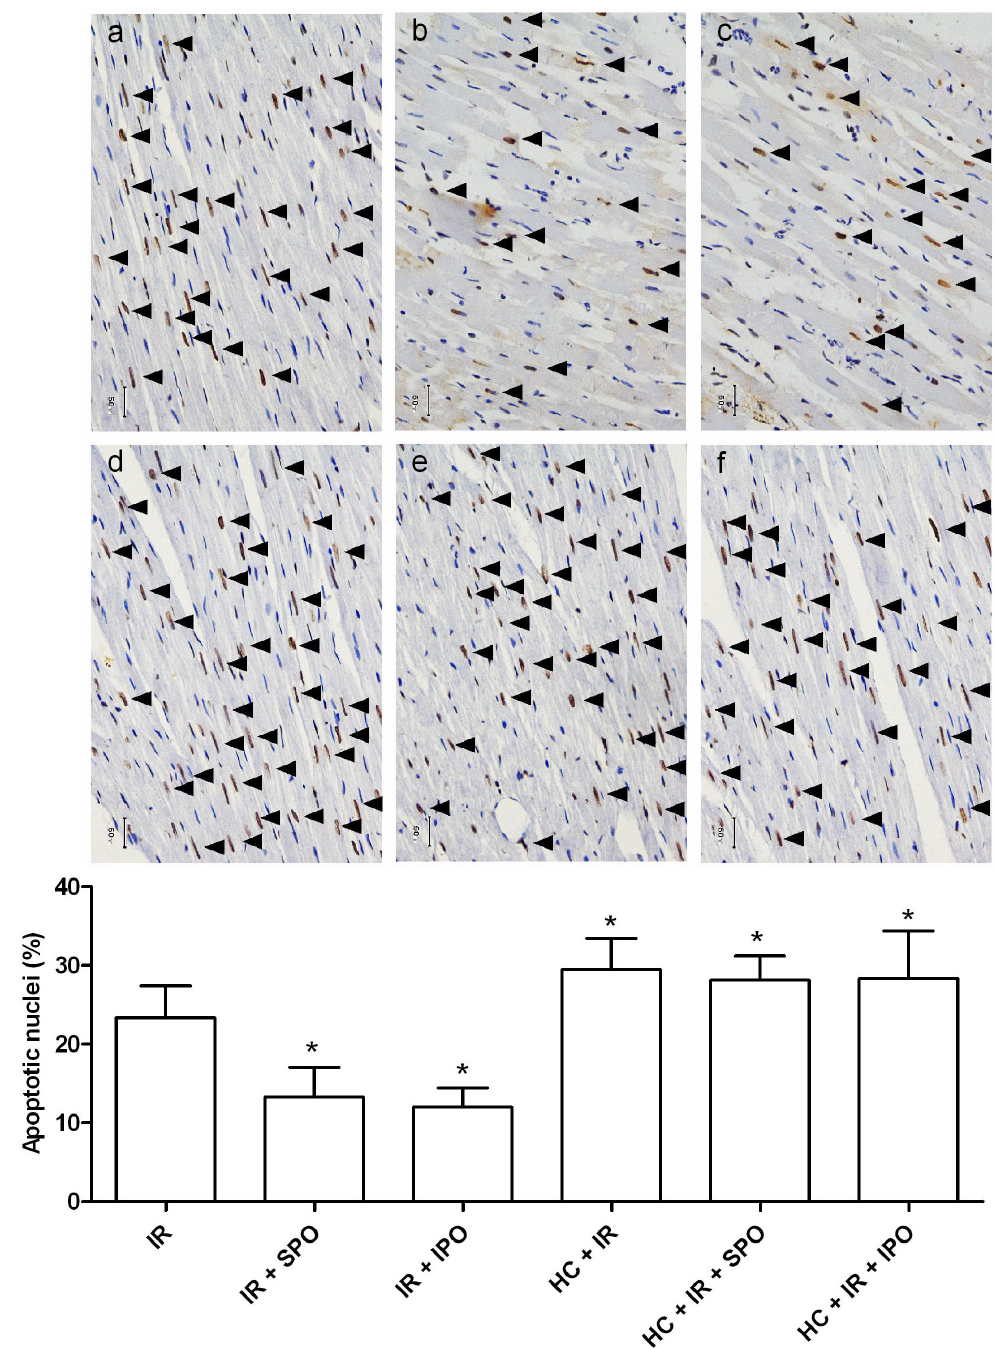
Figure 3. Effects of sevoflurane and ischemic postconditioning on apoptosis expressed as a percent of total nuclei in tissue sections from rat hearts exposed to ischemia-reperfusion (TUNEL staining, 400×). TUNEL-positive nuclei (brown nuclei) was indicated by the arrow. a normocholesterolemic ischemia reperfusion group (IR), b normocholesterolemic sevoflurane postconditioning group (IR + SPO), c normocholesterolemic ischemic postconditioning group (IR + IPO), d hypercholesterolemic ischemia reperfusion group (HC + IR), e hypercholesterolemic sevoflurane postconditioning group (HC + IR + SPO), f hypercholesterolemic ischemic postconditioning group (HC + IR + IPO). IR: ischemia reperfusion; SPO: sevoflurane postconditioning; IPO: ischemic postconditioning; HC: hypercholesterolemia. Data are mean ± SD, n = 6 hearts/group. * P < 0.05 vs . IR. doi: 10.1371/journal.pone.0076652.g003 PLOS ONE |